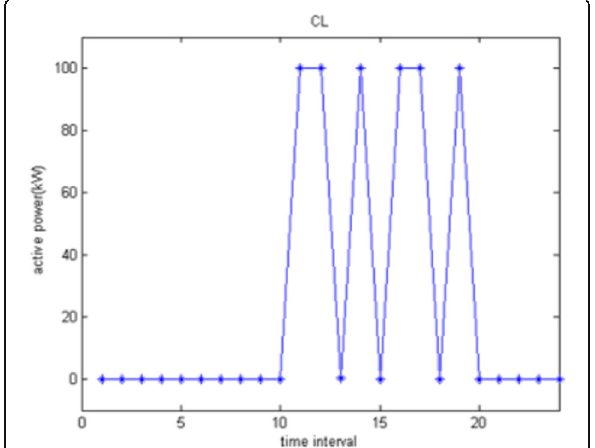
Fig. 17 Active power schedule of the Shapeable